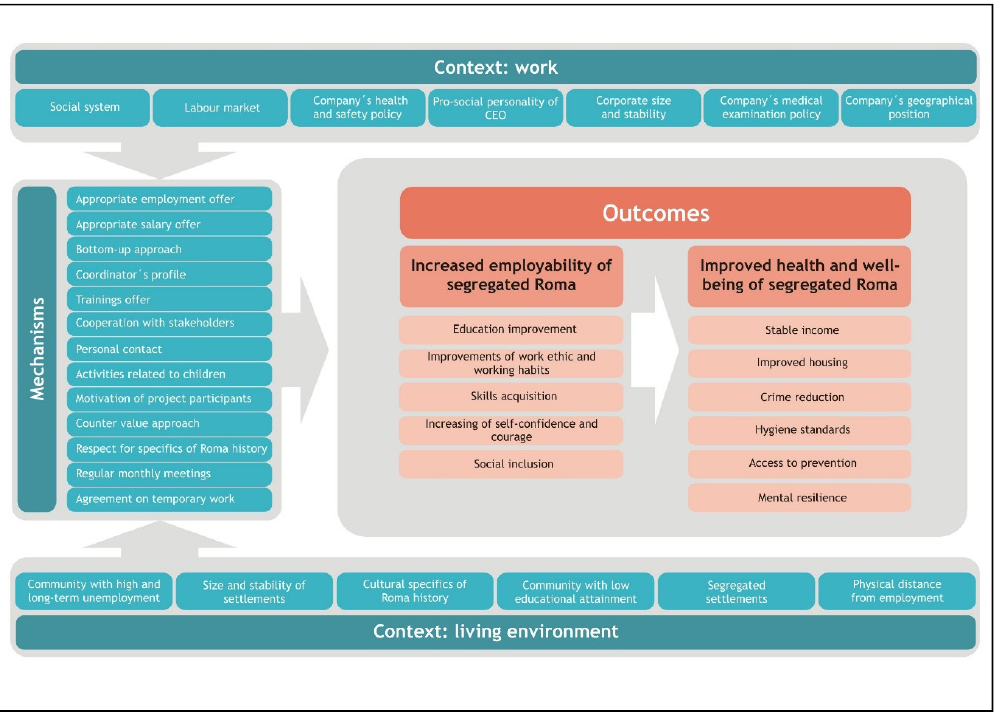
Figure 1. CMO framework of factors leading to increased employability of segregated Roma leading to their better well-being and